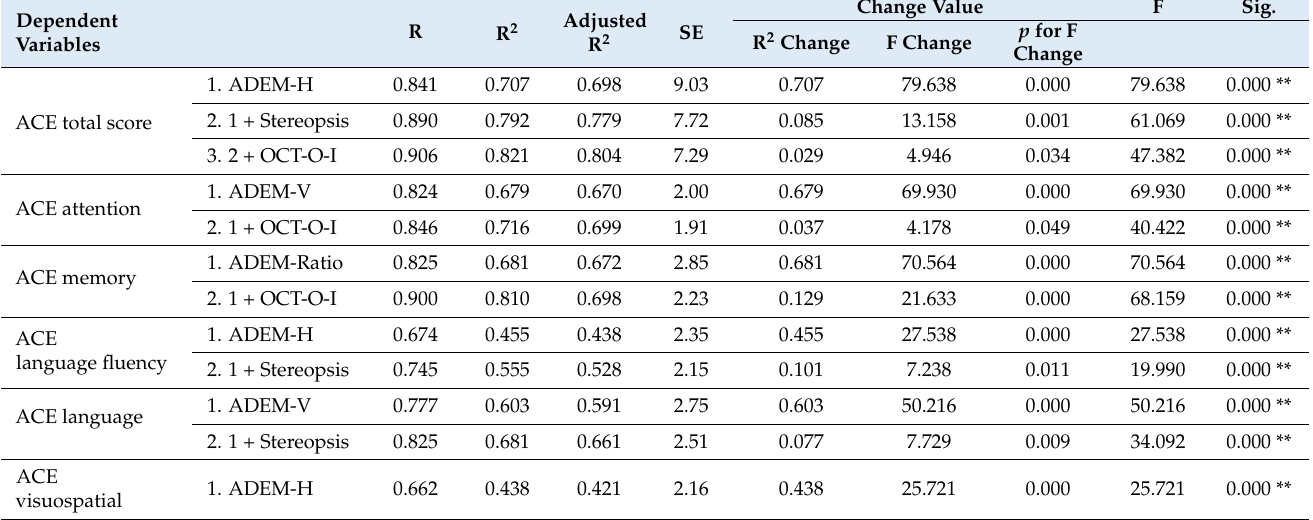
Table 4. Linear regression analysis on significant variables.